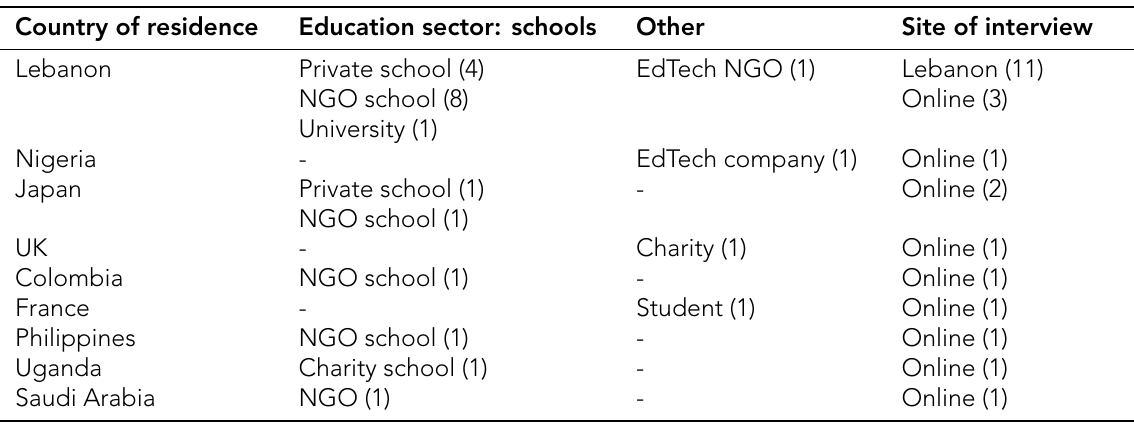
Table 1. Interviewee details (Source: Authors,